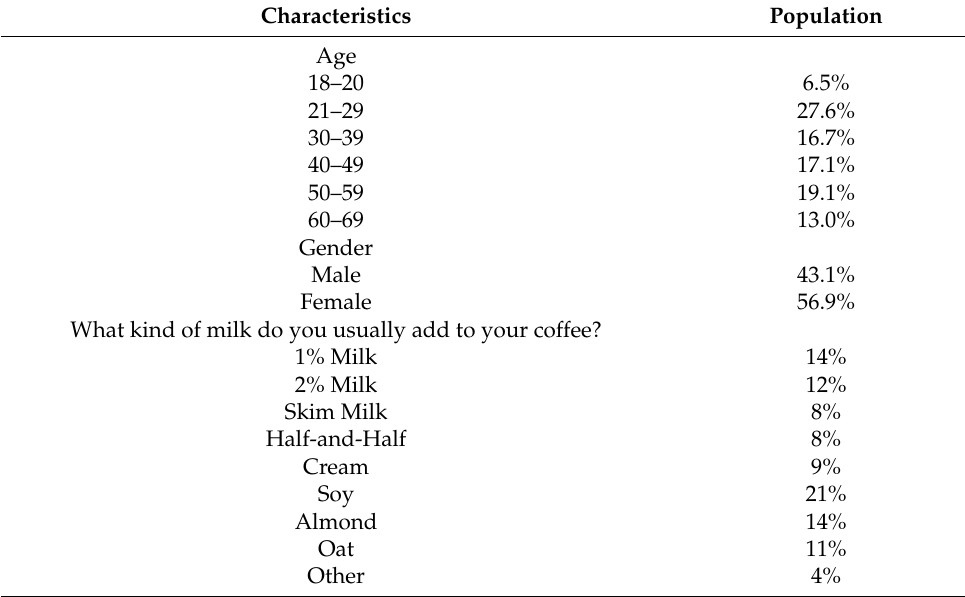
Table 1. Demographic details for the participants ( n =